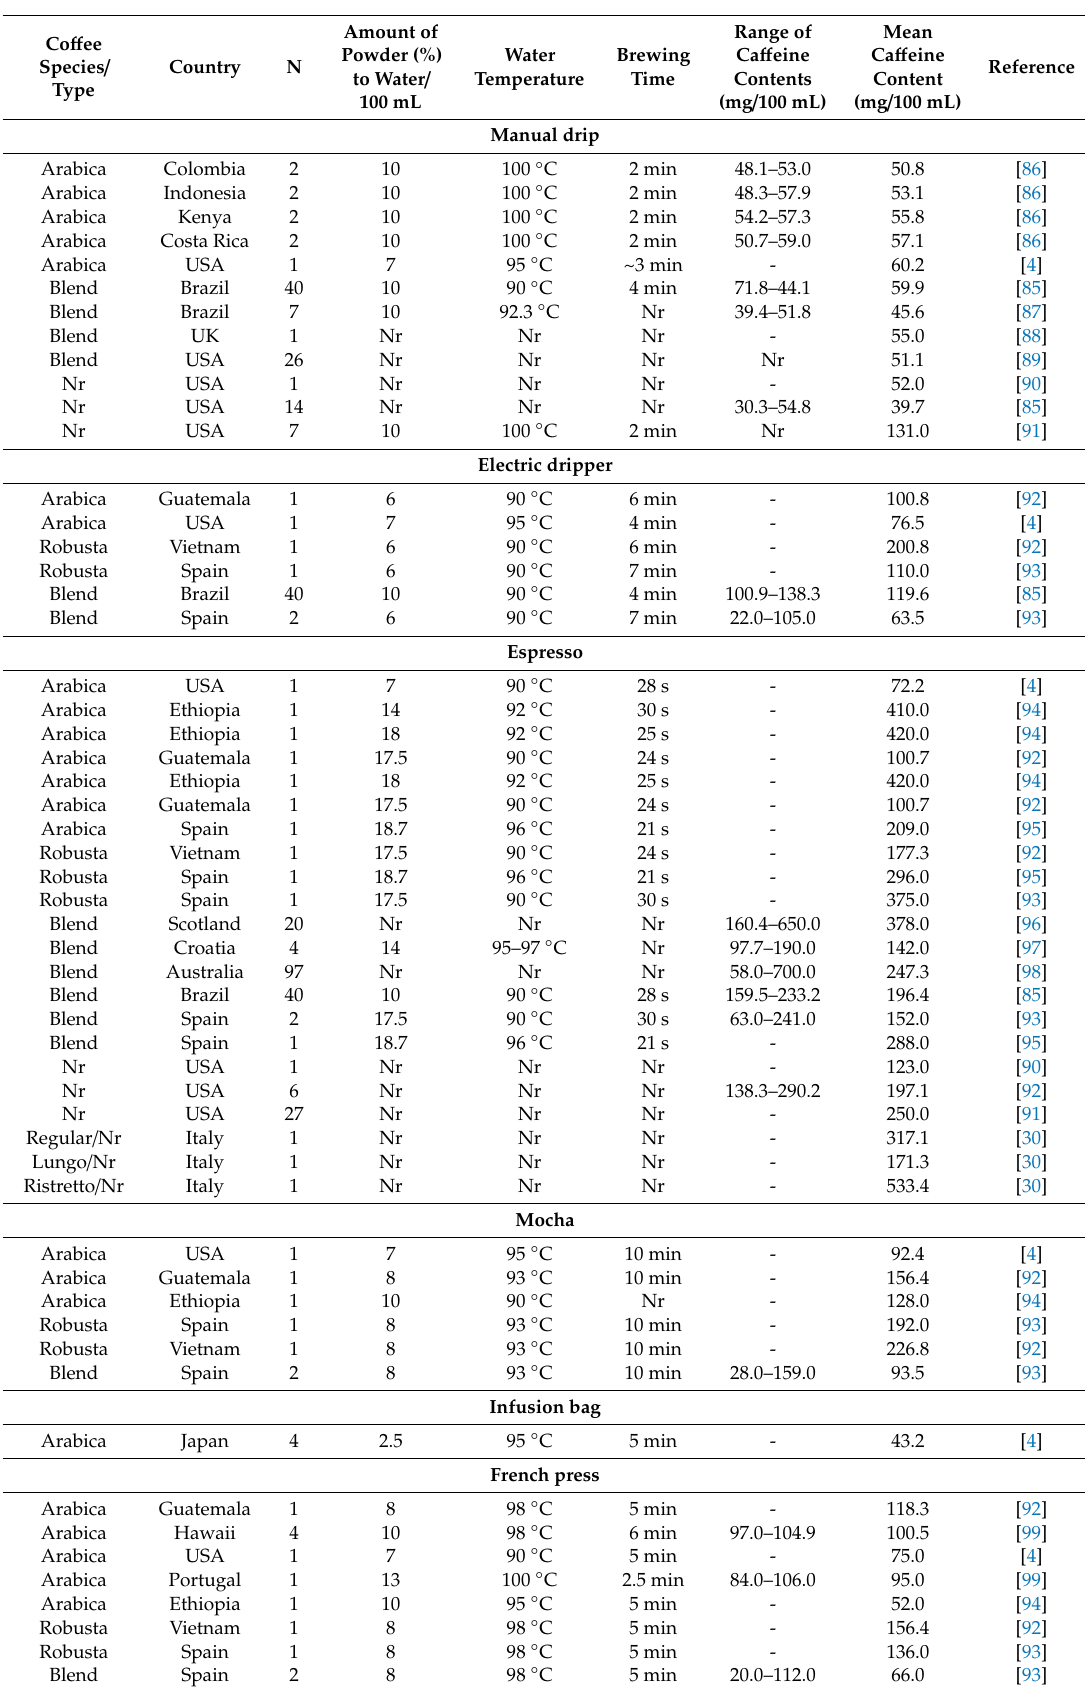
Table 2. Ca ff eine contents in co ff ee brews obtained by di ff erent extraction